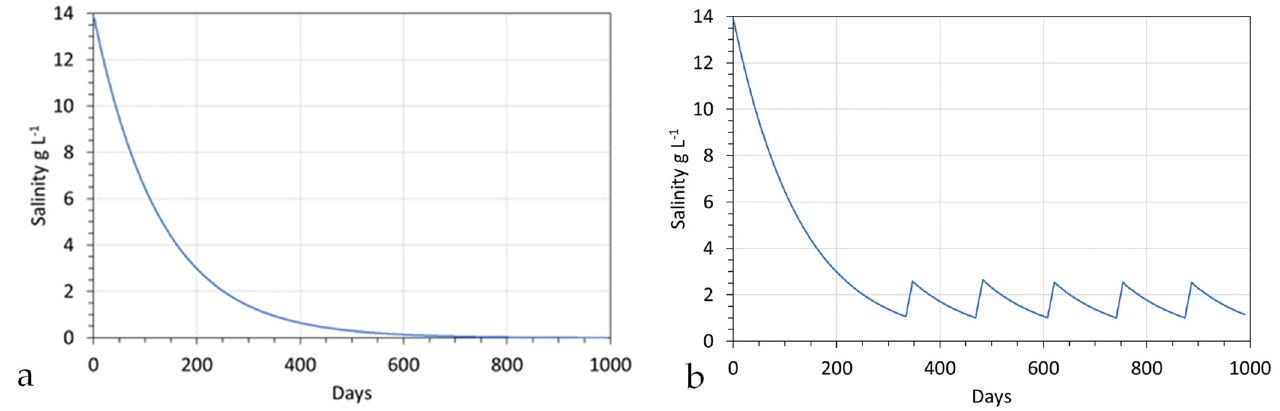
Figure 8. Contaminant concentration in a 100,000 m 3 stationary plume, with abstraction of 960 m 3 d − 1 . ( a ), The expected contaminant concentration if 960 m 3 d − 1 is reinjected into the plume; ( b ), Expected contaminant concentration if 960 m 3 d − 1 is reinjected into the plume to maintain its structure; and when the salinity is between 1 g L − 1 and 2.5 g L − 1 , 960 m 3 d − 1 is abstracted for anthropogenic use.